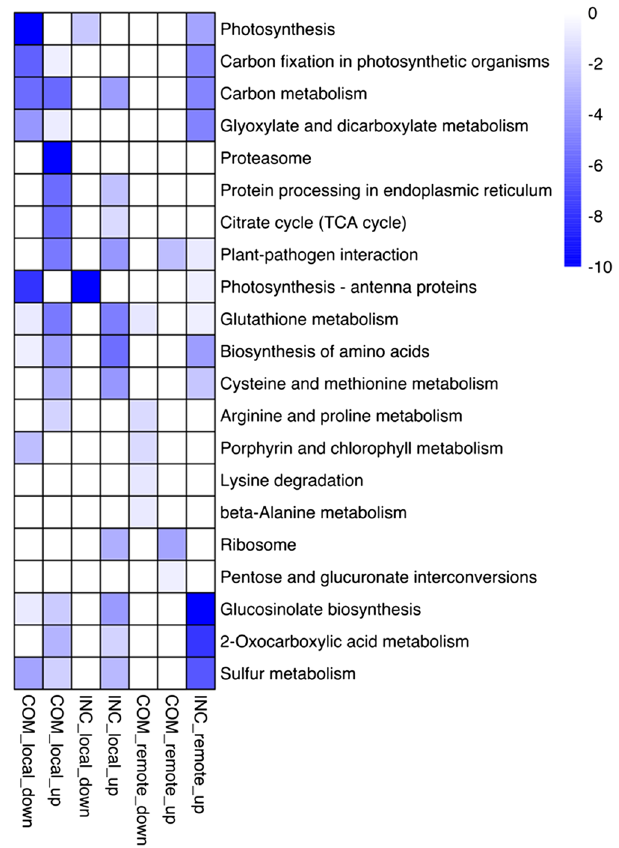
Figure 5. KEGG pathways enriched for up- and down-regulated DEGs in COM-local, INC-local, COM-remote and INC-remote treatments. Pathways with a significant adjusted p -value (< 0.05) are shown in association with colors from white (high) to blue (low), as defined in the